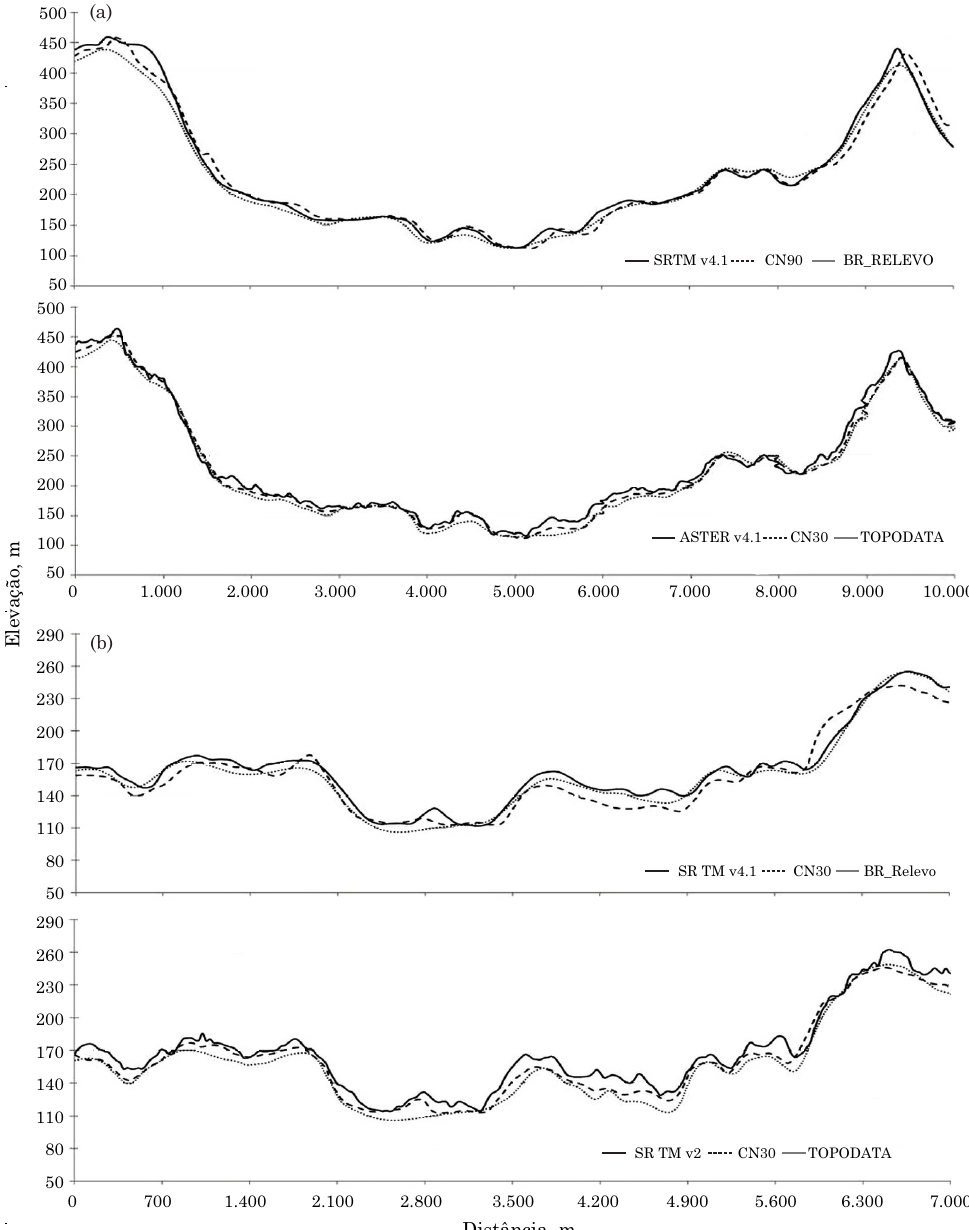
Figura 3. Perfis de elevação no transecto A-A‘ (a) e no transecto B-B‘ (b) dos modelos digitais de